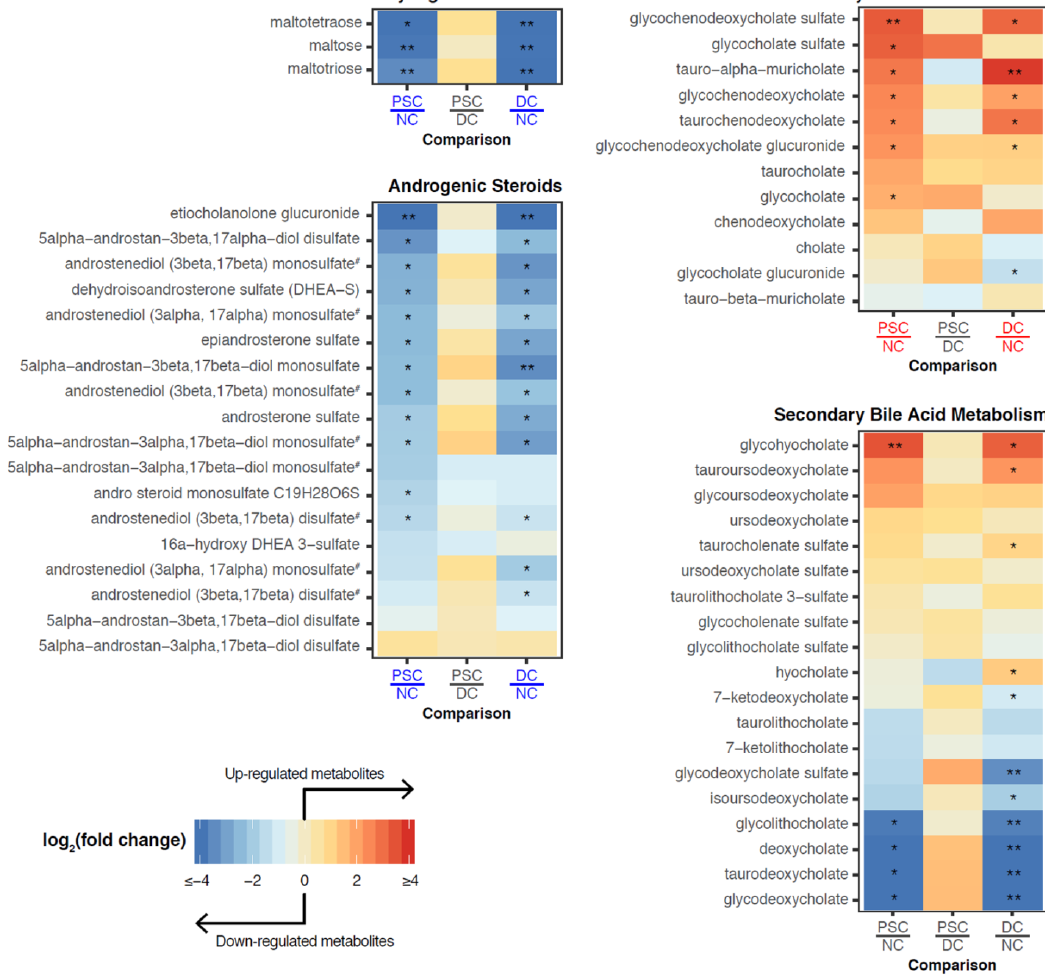
Figure 5. Heatmaps showing fold changes of individual metabolites from portal serum belonging to the subpathways of interest. Labels for phenotype comparisons were colored according to the metabolite set enrichment analysis results. Specifically, a label is colored red (blue) if the subpathway is significantly enriched with upregulated (downregulated) metabolites for the comparison. Metabolites that passed our criteria for differential abundance are marked with either a single asterisk (FC > 2 and FDR < 0.1) or double asterisks (FC > 10 and FDR < 0.01). # Metabolites measured more than once on the same LC-MS platform but with different retention time/index.